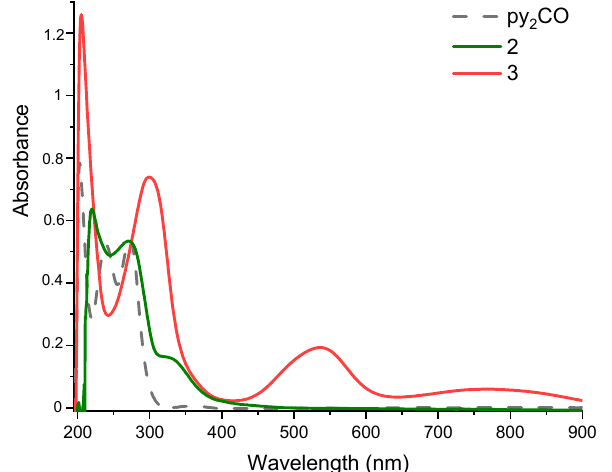
Figure 4. UV-Vis spectra for 2 and 3 (solid) along with py 2 CO (dashed) in ethyl acetate.